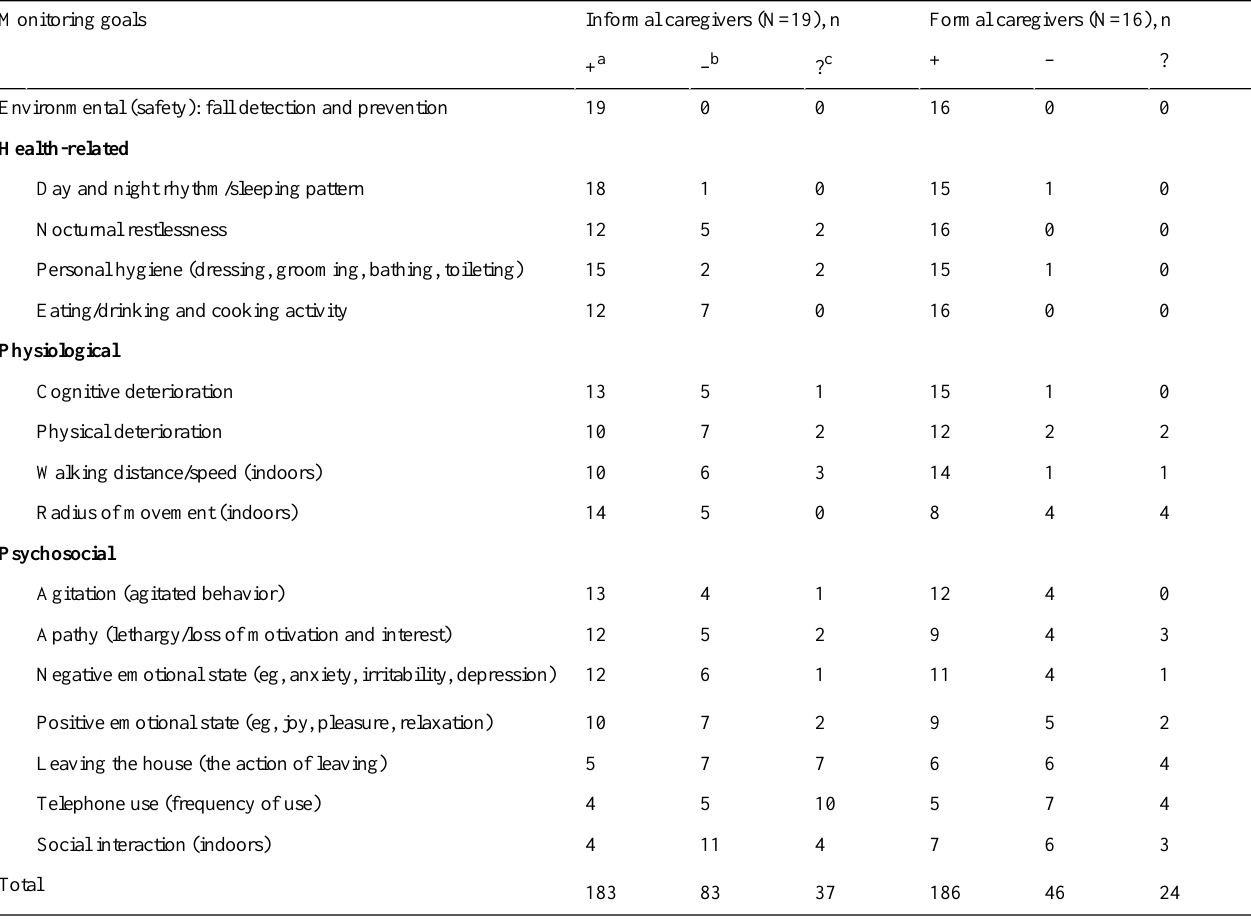
Table 3. Judgments of informal and formal caregivers of community-dwelling people with dementia for specific unobtrusive in-home monitoring